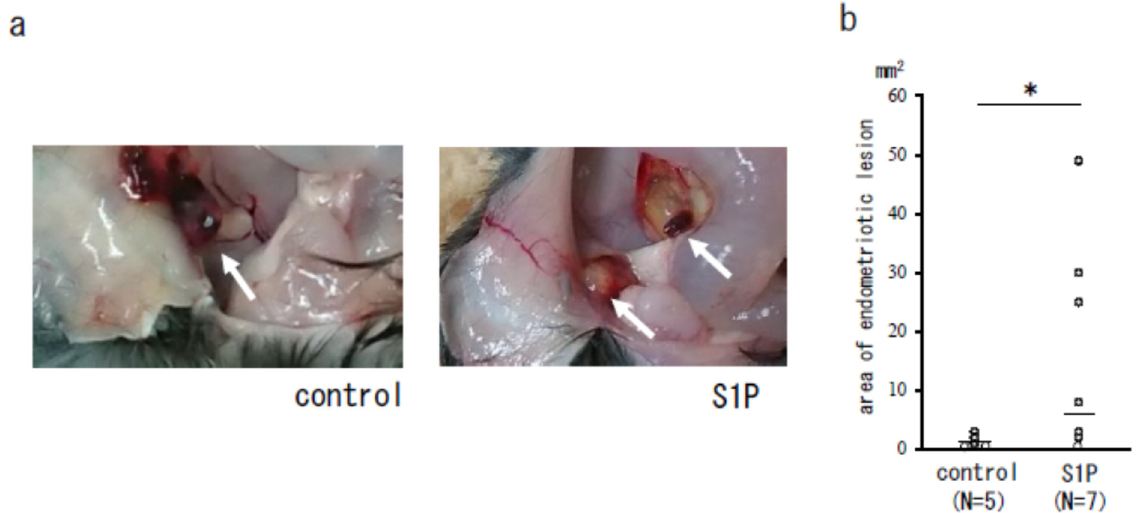
Figure 3. The S1P effect on an endometriosis mouse model. S1P (400 ng/mouse) or control (PBS) was administered for five consecutive days starting from the day the endometrium was inoculated into the peritoneal cavity of the mice. The recipient mice were euthanized on day 6, and the peritoneal cavity of each mouse was examined. The white arrows indicate the endometriotic-like lesions ( a ). Endometriotic-like lesions were measured for the total area of the lesion (mm 2 ) per mouse ( b ). Bars show the median value. *, p < 0.05.